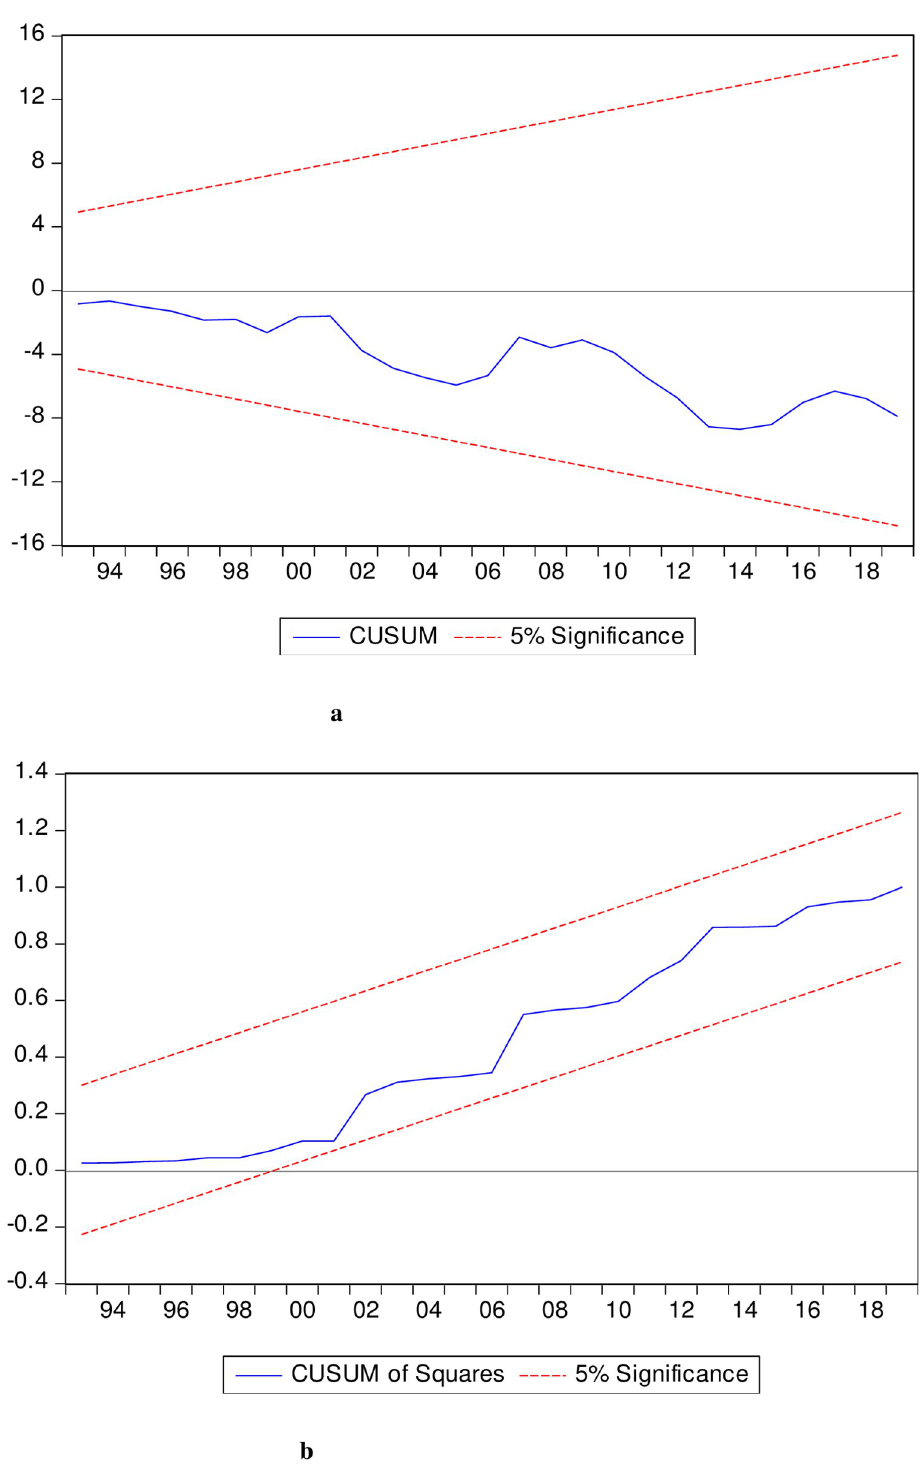
Fig 2. a. Results of cumulative sum of test. b. Results cumulative sum of squares test.